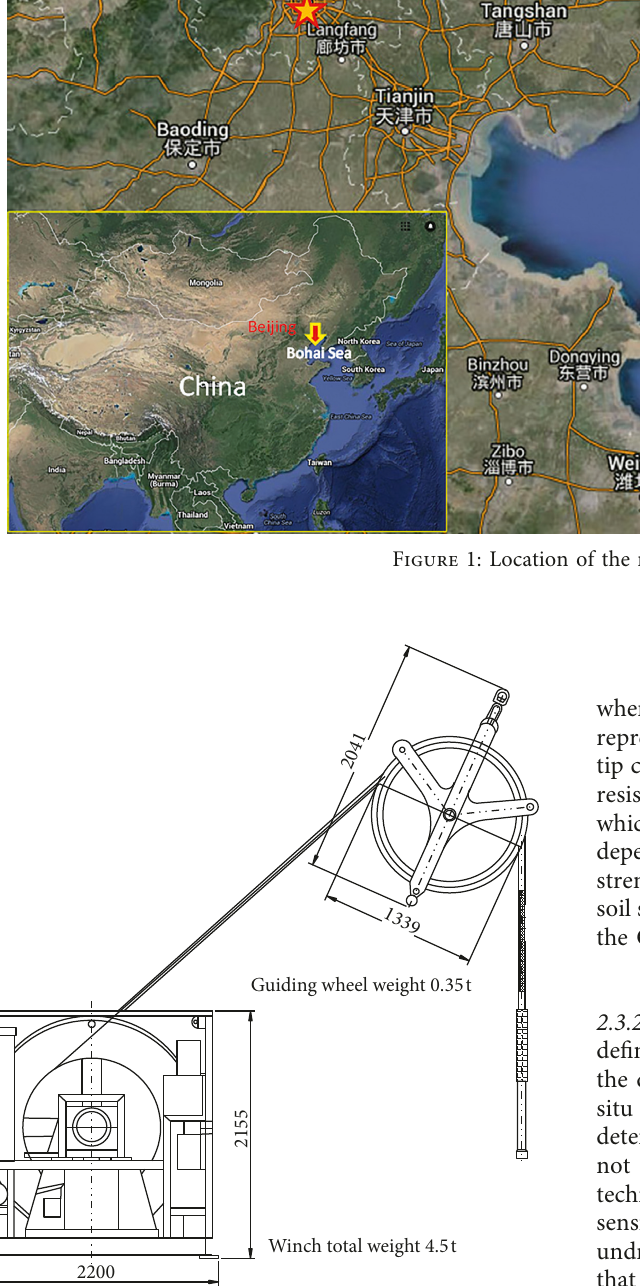
Figure 2: Wison-APB downhole CPTsystem (AP van den Berg,